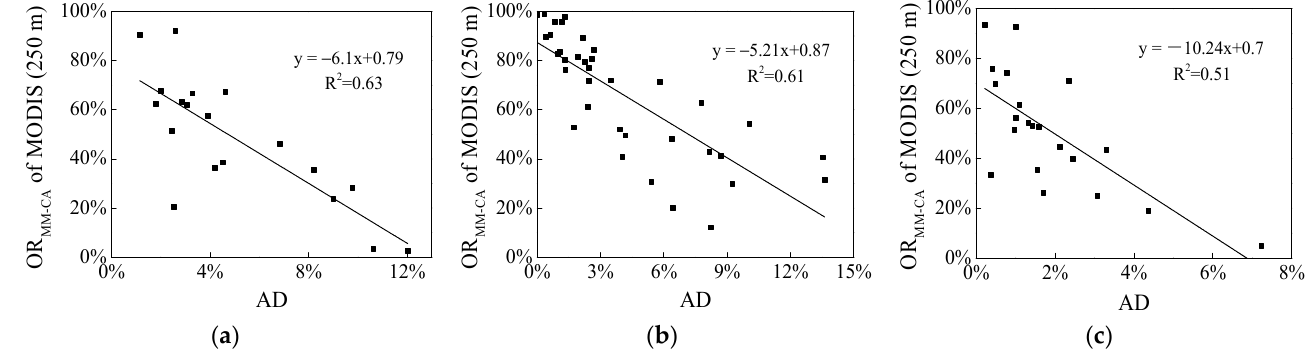
Figure 5. Changes in the omission rate (OR MM-CA ) of MODIS (250 m) image with the aggregation density (AD) of macroalgae in the subzones. ( a – c ) are corresponding to the group A–C, respectively. On the basis of the MM-CA calculated for the above-mentioned subzones (as shown in Figure 3), the relationship in the MM-CA between the low resolution image and the corresponding high resolution image is analyzed. As shown by Figure 6, in general, there